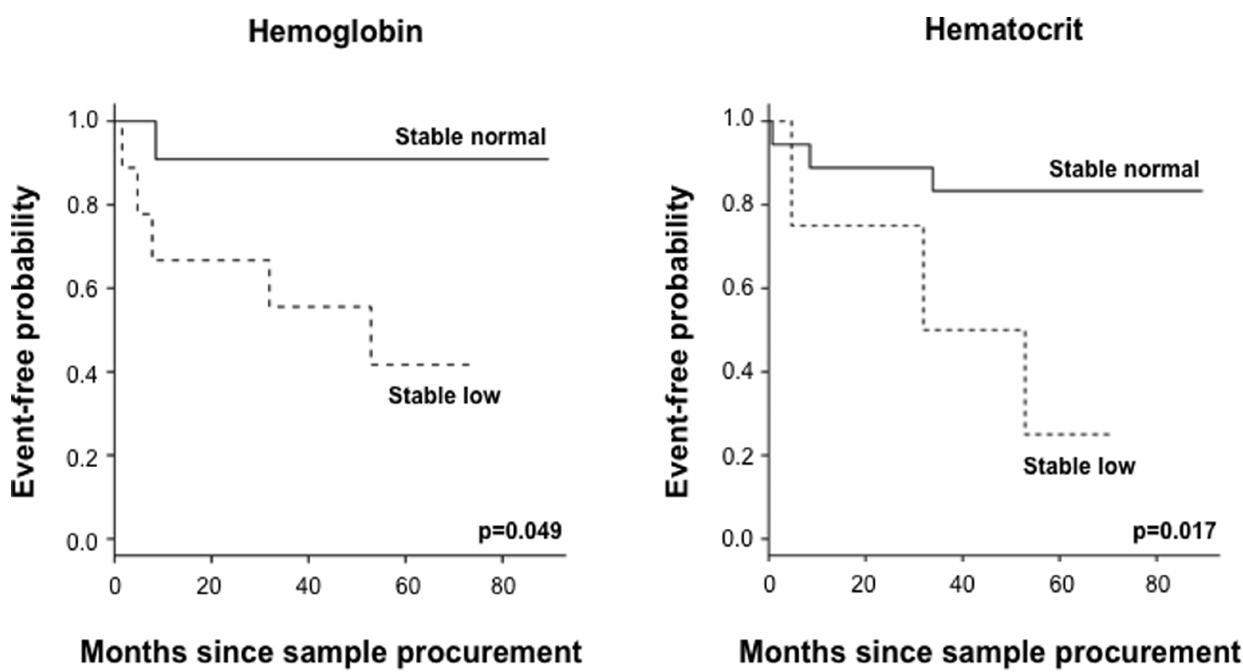
Figure 2. Serial measurements of hemoglobin (Hgb) during follow-up and association with complicated Crohn’s disease - Kaplan- Meier survival analysis for event-free probability. The broken line represents the population with low Hgb ( , 14.2 g/dl for males and , 13.3 g/ dl for females) or low Hct ( , 40% for males and , 37% for females), respectively. The full line represent the population with normal Hgb or Hct. P- value as indicated in the figure. doi:10.1371/journal.pone.0104706.g002 PLOS ONE |